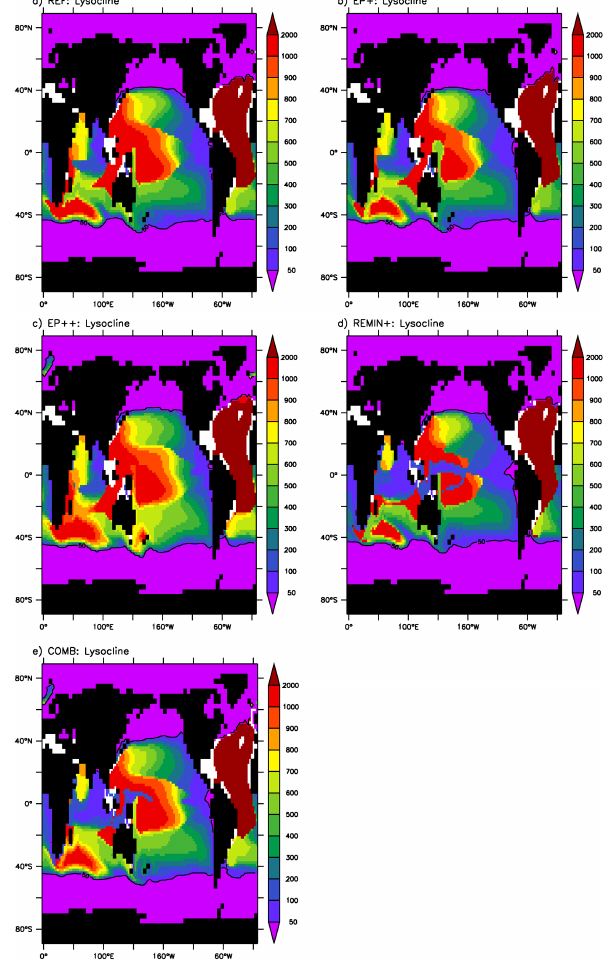
Figure 6. Annual mean depth of the aragonite lysocline (m) dur- ing the 2090–2100 period for: (a) REF; (b) EP+; (c) EP++; (d) REMIN+; and (e) COMB simulations.